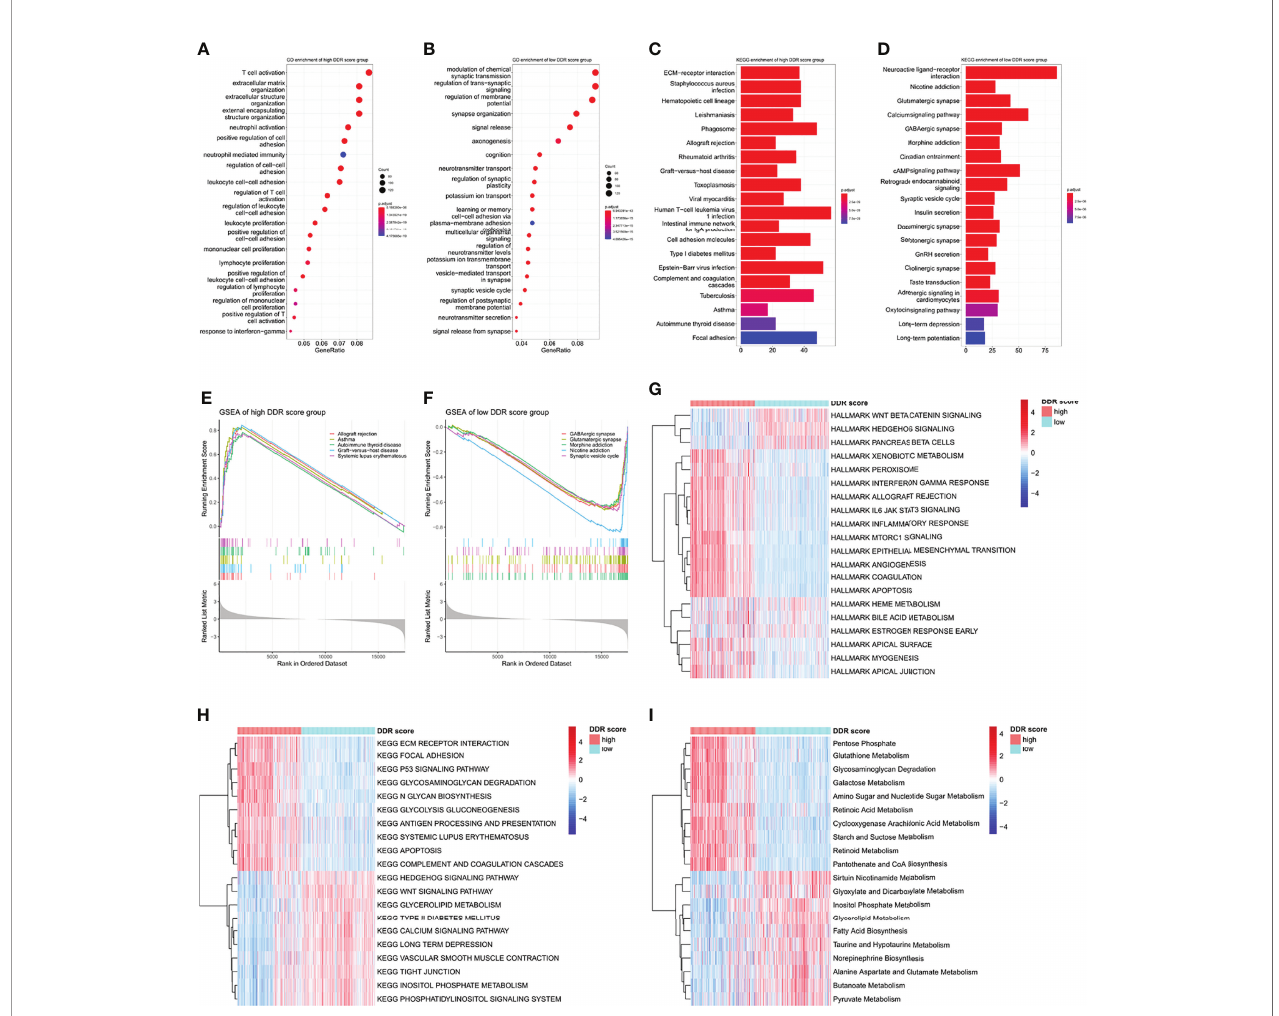
FIGURE 4 | Functional annotations and pathway enrichment analyses of DDR score subtypes (A, B) GO annotations of the high and low DDR score groups. (C, D) KEGG analysis of the high and low DDR score groups. (E, F) GSEA of the high and low DDR score groups. (G, H) HALLMARK and KEGG signature enrichment of high and low DDR score subtypes calculated by the ssGSEA algorithm. (I) The differentially enriched metabolic processes in high and low DDR score